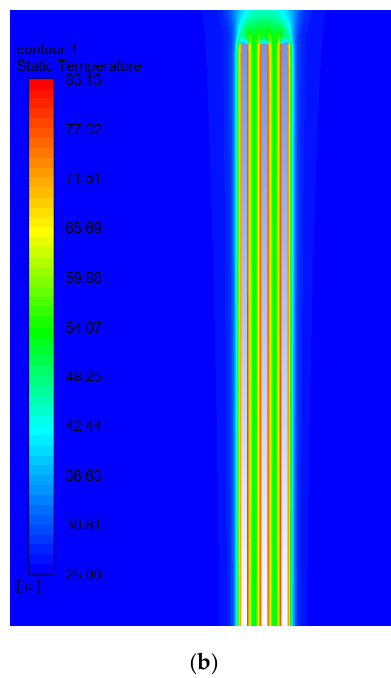
Figure 9. Temperature distribution around power cables (load equal to 176.2 A as permissible in the ground of the soil resistivity 1.0 (K·m)/W): ( a ) with solar radiation (max insulation temp. 102.50 °C); ( b ) without solar radiation (max insulation temp. 83.13 °C).